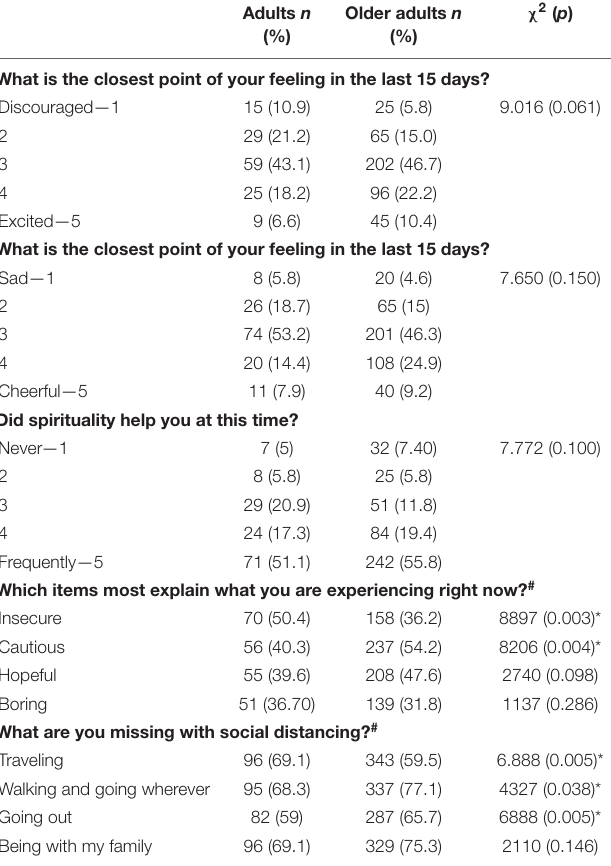
TABLE 4 | Dietary habits of adults ( n = 139) and older adults ( n = 437) during social distancing due to the COVID-19 pandemic. Adults n (%) Older adults n (%) χ 2 ( p )